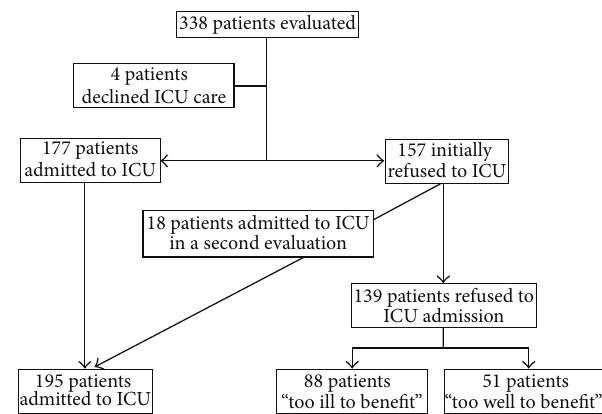
Figure 1: Flow chart of inclusion and exclusion